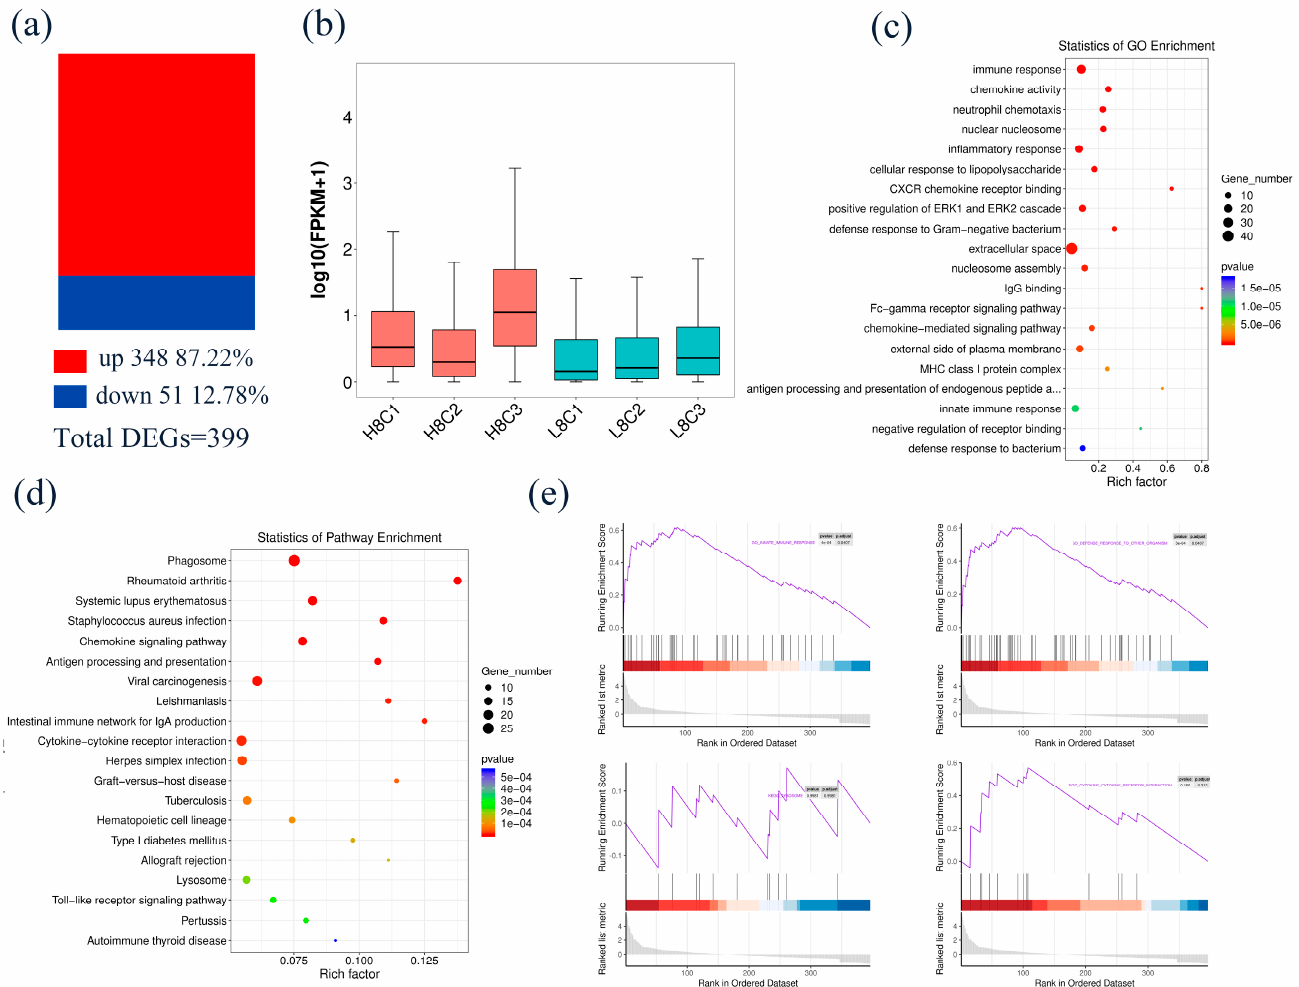
Figure 3. Identification and functional analysis of DEGs in 8-cell-stage embryo. ( a ) Comparing H8C with L8C, a total of 399 DEGs were identified, including 348 up-regulated and 51 down-regulated DEGs. ( b ) Boxplot of FPKM between H8C and L8C. ( c , d ) The GO and KEGG enrichment analyses of the DEGs. ( e ) The DEGs were enriched in cytokine–cytokine receptor interactions, lysosomes, innate immune responses, and defense response to Gram-negative bacterium.